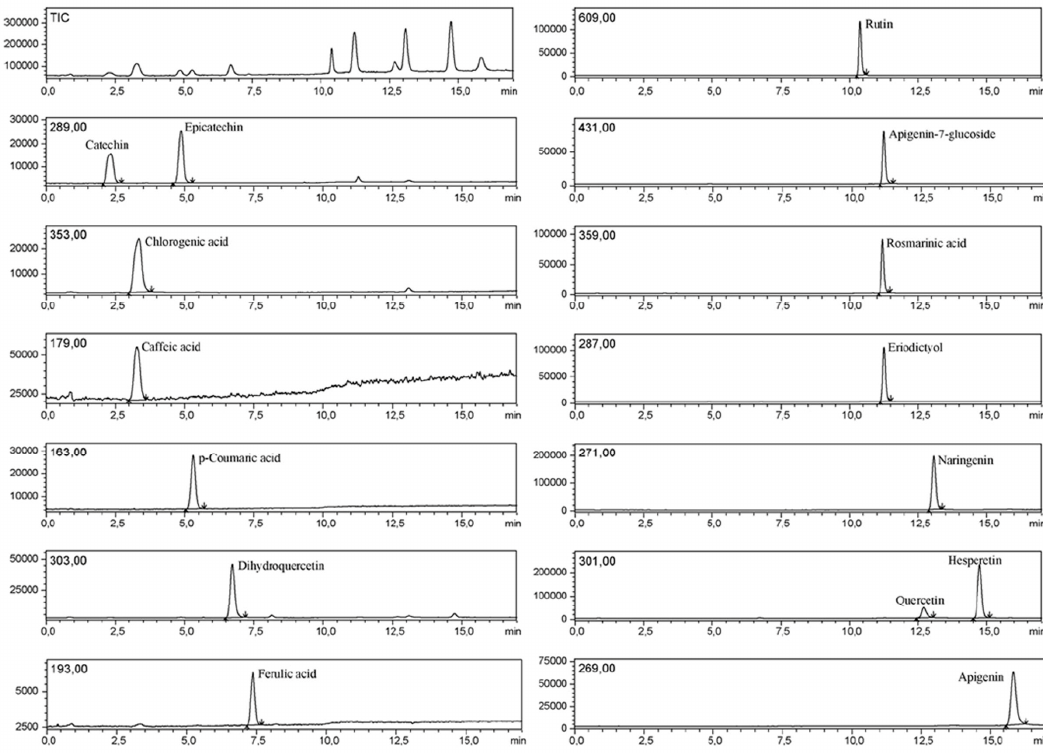
Figure 20. LC-MS chromatograms of standards for the 15 phenolic compounds obtained in SIM (single ion monitoring) mode and the total ion chromatogram (TIC). Reproduced with permission from [64]. Copyright Elsevier, 2010.